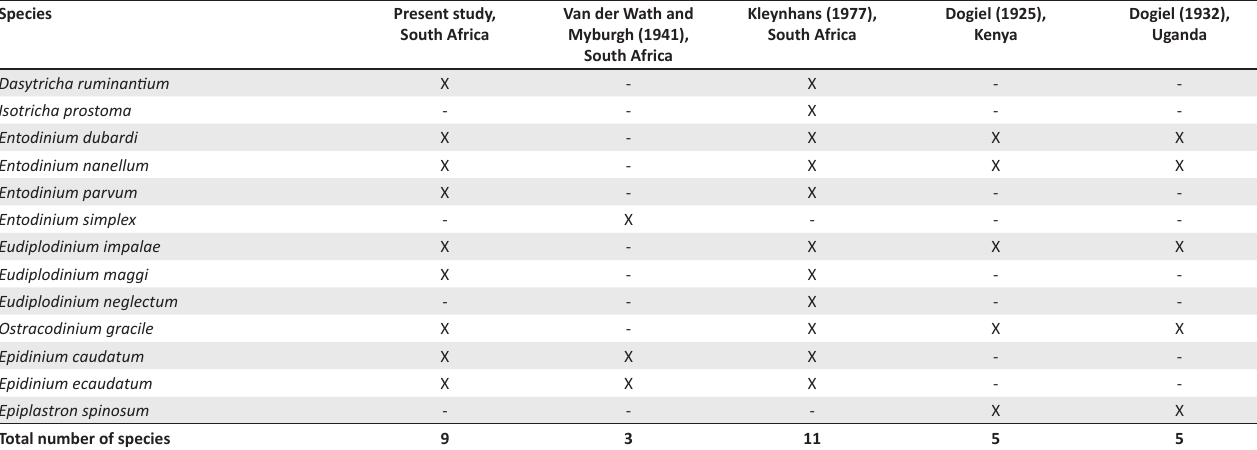
TABLE 1: Rumen protozoa observed from impala ( Aepyceros melampus ).